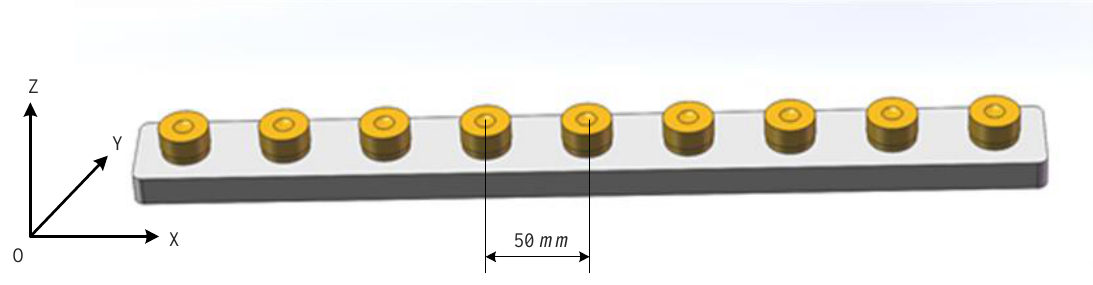
Figure 2. The linear elliptical paraboloid array.